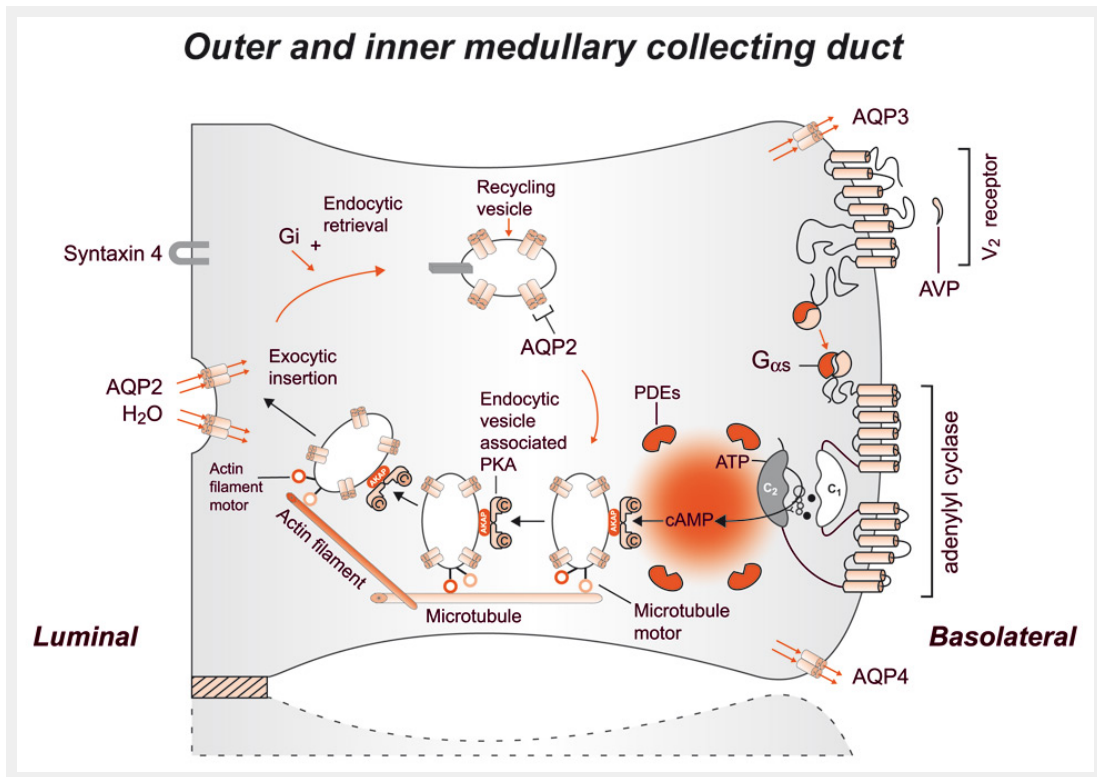
Figure 5 Schematic representation of the effect of vasopressin (AVP) to increase water permeability in the principal cells of the collecting duct. AVP is bound to the V 2 receptor (a G-protein-linked receptor) on the basolateral membrane. The basic process of G-protein-coupled receptor signalling consists of three steps: a hepta-helical receptor that detects a ligand (in this case, AVP) in the extracellular milieu, a G-protein (G αs ) that dissociates into■■  ■■ subunits bound to GTP and ■■  ■■ subunits after interaction with the ligand-bound receptor, and an effector (in this case, adenylyl cyclase) that interacts with dissociated G-protein subunits to generate small-molecule second messengers. AVP activates adenylyl cyclase, increasing the intracellular concentration of cAMP. The topology of adenylyl cyclase is characterised by two tandem repeats of six hydrophobic transmembrane domains separated by a large cytoplasmic loop and terminates in a large intracellular tail. The dimeric structure (C 1 and C 2 ) of the catalytic domains is represented. Conversion of ATP to cAMP takes place at the dimer interface. Two aspartate residues (in C 1 ) coordinate two metal co-factors (Mg 2+ or Mn 2+ represented here as two small black circles), which enable the catalytic function of the enzyme (305). Adenosine is shown as an open circle and the three phosphate groups (ATP) are shown as smaller open circles. Protein kinase A (PKA) is the target of the generated cAMP. The binding of cAMP to the regulatory subunits of PKA induces a conformational change, causing these subunits to dissociate from the catalytic subunits. These activated subunits (C) as shown here are anchored to an aquaporin-2 (AQP2)-containing endocytic vesicle via an A-kinase anchoring protein. The local concentration and distribution of the cAMP gradient is limited by phosphodiesterases (PDEs). Cytoplasmic vesicles carrying the water channels (represented as homotetrameric complexes) are fused to the luminal membrane in response to AVP, thereby increasing the water permeability of this membrane. The dissociation of the A-kinase anchoring protein from the endocytic vesicle is not represented. Microtubules and actin filaments are necessary for vesicle movement toward the membrane. When AVP is not available, AQP2 water channels are retrieved by an endocytic process, and water permeability returns to its original low rate. Aquaporin-3 (AQP3) and aquaporin-4 (AQP4) water channels are expressed constitutively at the basolateral membrane. (From: Bonnardeaux A, Bichet DG. Inherited disorders of the renal tubule. In: Brenner BM (ed). The Kidney. 8th ed. New York: Harcourt Health Sciences; 2008. p. 1382-1419. © Elsevier, Oxford, UK, with kind